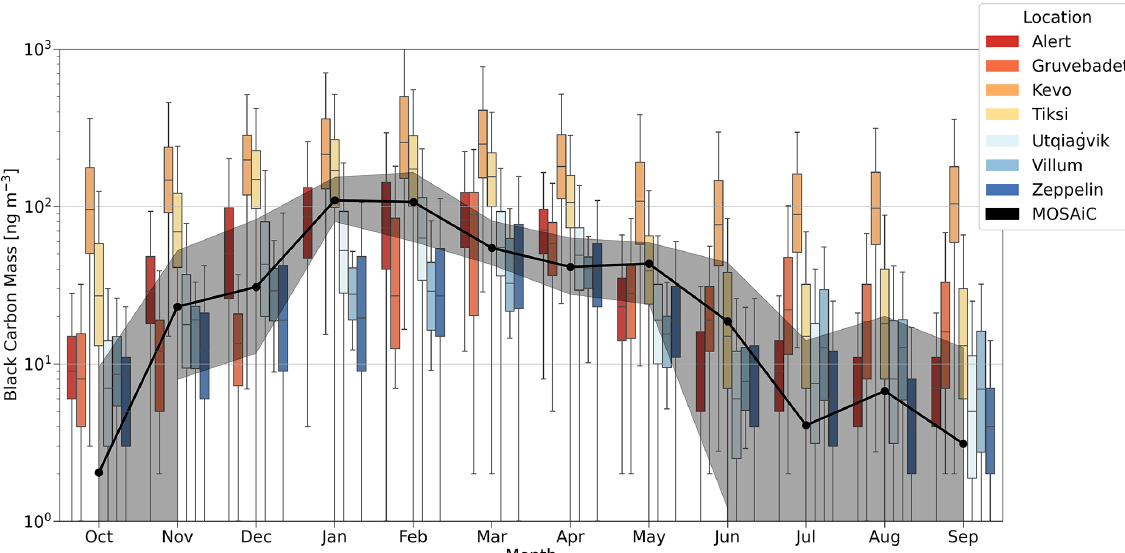
Figure 10. A comparison of BC mass concentrations in the Arctic between land-based observatories and MOSAiC. The MOSAiC BC mass concentrations (black line, Aethalometer) are displayed as monthly medians, and the shaded region shows the interquartile range. The boxes for the various sites represent BC and EC mass concentrations spanning several decades, where the time range varies by site (Alert: 1989– 2017, Gruvebadet: 2010–2018, Kevo: 1964–2010, Tiksi: 2009–2018, Utqia˙gvik: 1991–2019, Villum: 2009–2018, Zeppelin: 2001–2017). See Sect. 2.3 for details on the BC measurement methods, and refer to Schmale et al. (2022) for details on the long-term measurements from the land-based